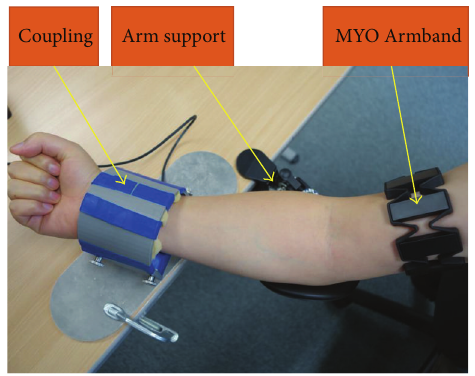
Figure 8: Stiffness variation estimation hardware